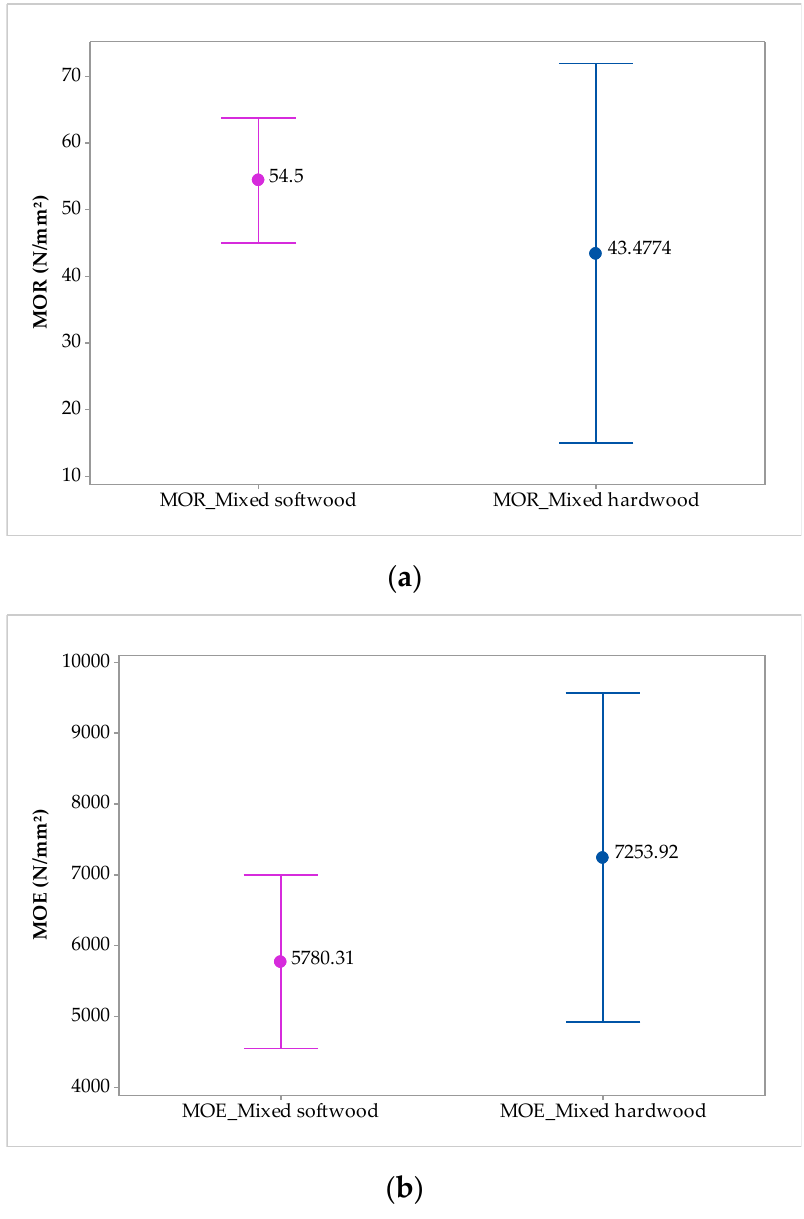
Figure 4. Interval plot of analyzed properties for OSB types: ( a ) modulus of rupture (MOR); ( b ) modulus of elasticity (MOE) .